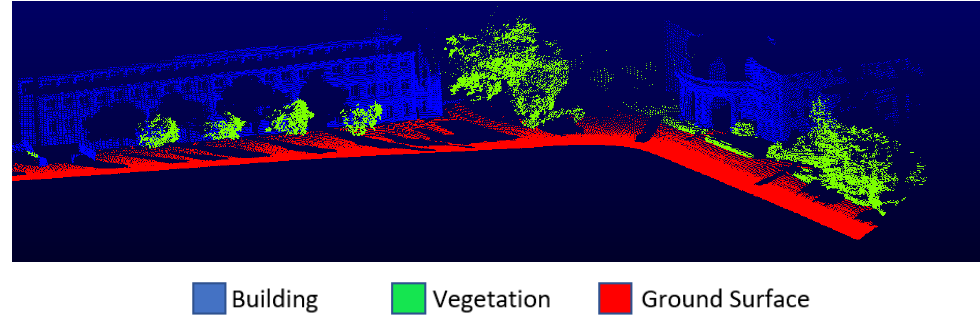
Figure 5. Testing samples from the Oakland dataset.